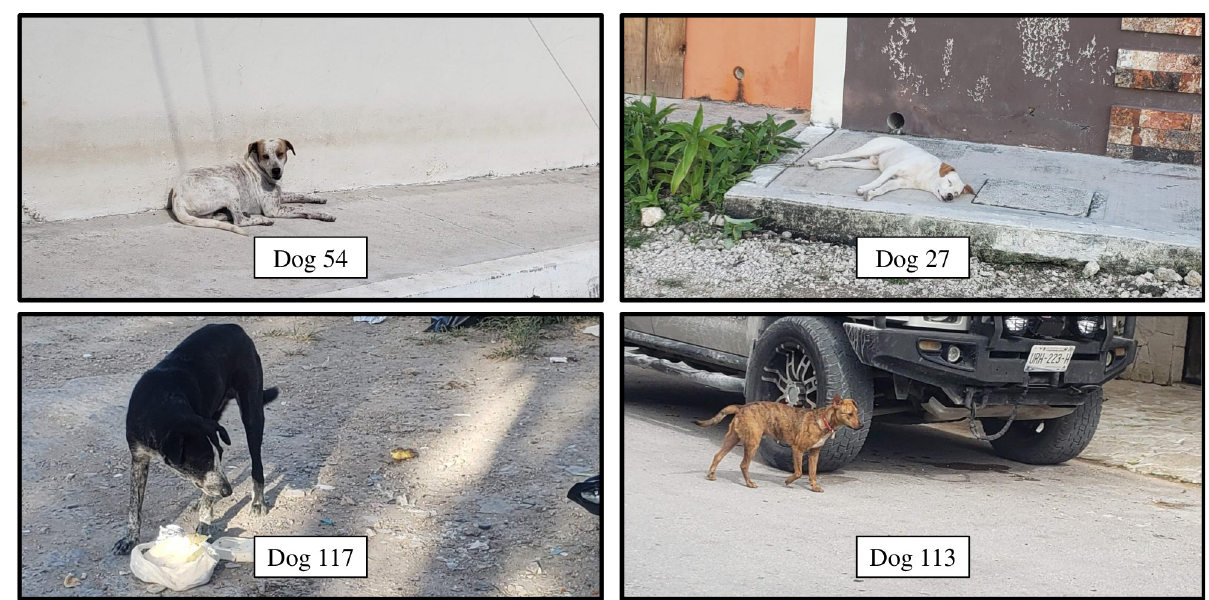
Fig 2. Four dogs from Tulu´m, individually distinguishable by phenotypic variation. The top two panels show a pair of individual dogs with similar features but are distinguishable by the extent of brown coloration on their faces. The bottom two panels show two dogs that are clearly different